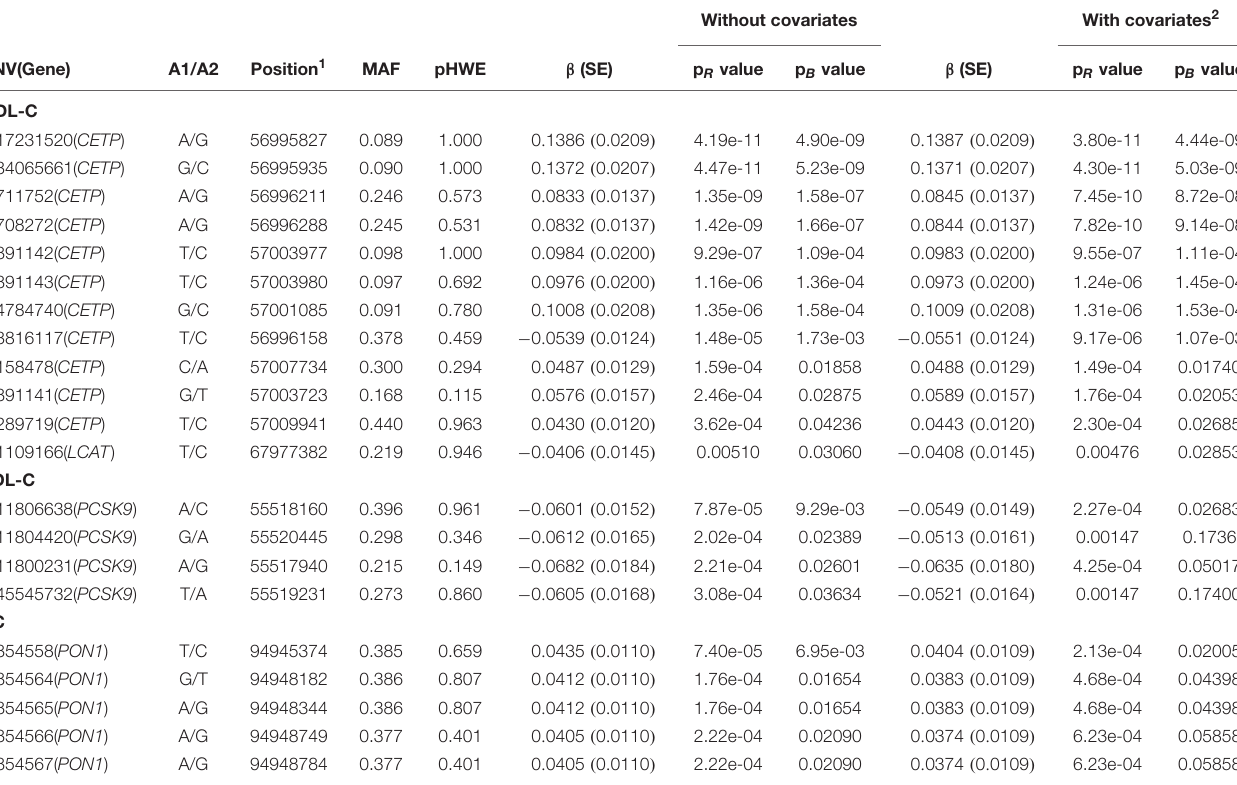
TABLE 3 | Association of single nucleotide variants of selected candidate genes with lipid levels among the total study group ( n = 1855). Without covariates With covariates